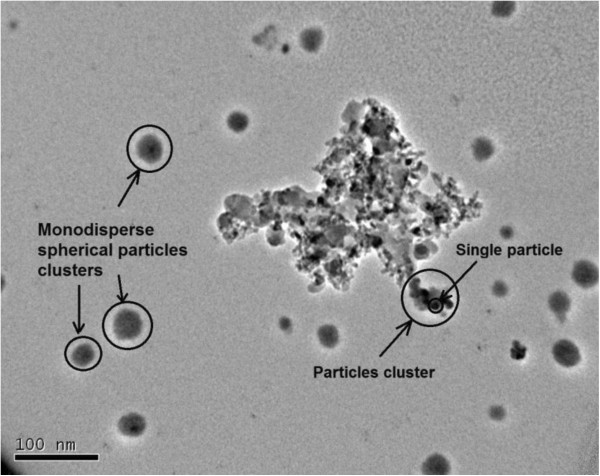
TEM nanographs of 15 nm TiO2nanoparticles.